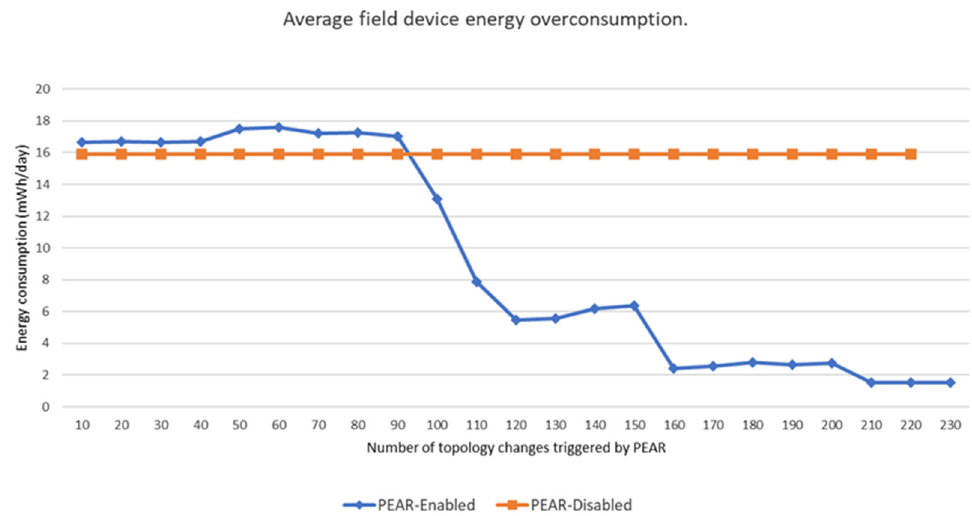
Figure 9. Average field device overconsumption for a 24-month profile (i.e., 200 DPDU/min) with respect to the number of topology changes triggered by PEAR.